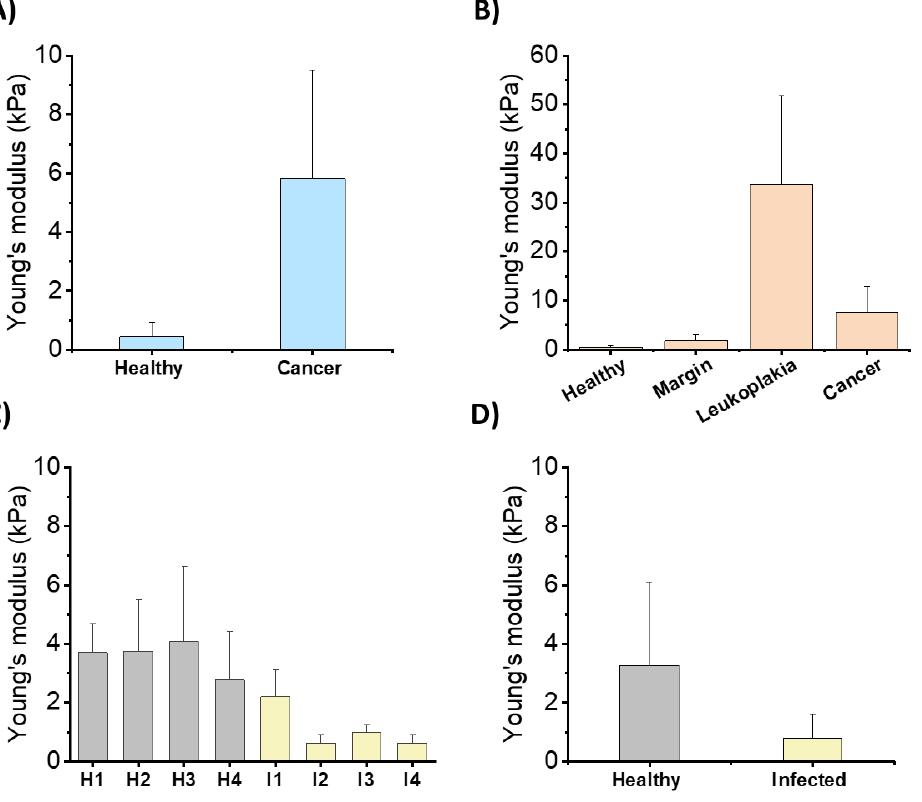
Figure 11. Young’s modulus values obtained for healthy and diseased tissues using the AFM indentation technique: ( A ) Average Young’s modulus values of healthy and colon cancer tissues. A sig- nificantly higher Young ’ s modulus of neoplastic tissues as compared to healthy tissues was shown. The greater stiffness of neoplastic tissues is associated with the presence of an increased amount of extracellular matrix protein. Collagen overexpression, matrix fibrosis, cross-linking, and vasculari- zation occur during tumor progression [33]. ( B ) Young’s modulus value distribution for healthy mouth mucosa and diseased tissues (leukoplakia and cancer). Differences between healthy tissue and tissue outside of the leukoplakia area are noticed. The stiffness of the leukoplakia samples was higher compared to the surrounding mucosa. Inhomogeneity of stiffness within leukoplakia sam- ples was observed, which might act as a mechano-agonist that promotes oncogenesis. Stiffness of cancer samples was significantly lower than that within the precancerous ones [33]. ( C ) Mechanical properties of healthy stomach tissues (H1-H4) and those infected with Helicobacter pylori (I1-I4). The mean values of tissues’ Young’s modulus ± standard deviation for each healthy and infected tissue [33]. ( D ) Rheological difference between healthy stomach tissue and tissue during inflammation caused by H. pylori infection. The mean values of tissues’ Young’s modulus ± standard deviation [33]. Since the first in vitro observation indicating the ability of the LL-37 peptide to in- crease the cell stiffness of epithelial cells, the new mechanism of LL-37 action might also be based on its ability to modulate viscoelastic properties of the cells and tissues. It has been shown that changes in cell and tissue mechanics under the influence of chronic mi- crobial colonization can, in the long term, disrupt transcriptional processes in the cell nu- clei of epithelial cells and thus cause cancer risk [33,33]. Studies of gastric tissues from children with confirmed H. pylori -induced inflammation indicated that the infected tis- sues had lower stiffness compared to healthy tissues. Since H. pylori can colonize the oral